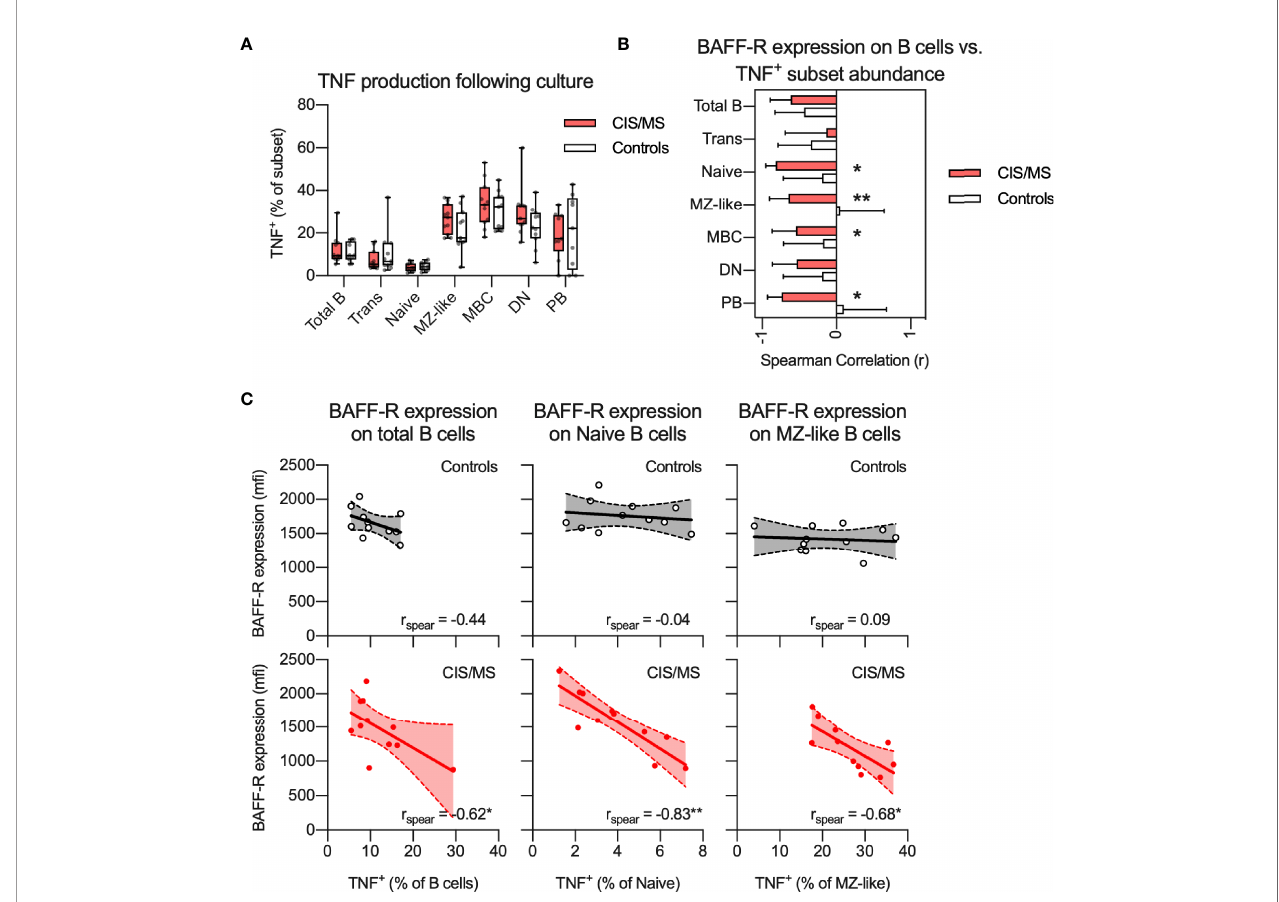
FIGURE 6 | (A) Proportion of TNF + B cell subsets following stimulation with R848 in CIS/MS patients and controls. (B, C) Non-parametric correlation between BAFF-R expression on BAFF-R + B cells and proportion of TNF + B cell subsets following R848 stimulation in CIS/MS patients and controls (B) as well as raw data for CIS/MS patients and controls (C) . Data in A and C are displayed for each participant, together with box/whiskers display for median and range where relevant (n CIS/MS = 11, n Controls = 11). Data in (B) are displayed as mean correlation ± 95% CI. Correlations are visualised using a linear fi t and 95% CI. Signi fi cance of correlation was calculated using Spearman non-parametric test displayed as p<0.01, **; p<0.05,